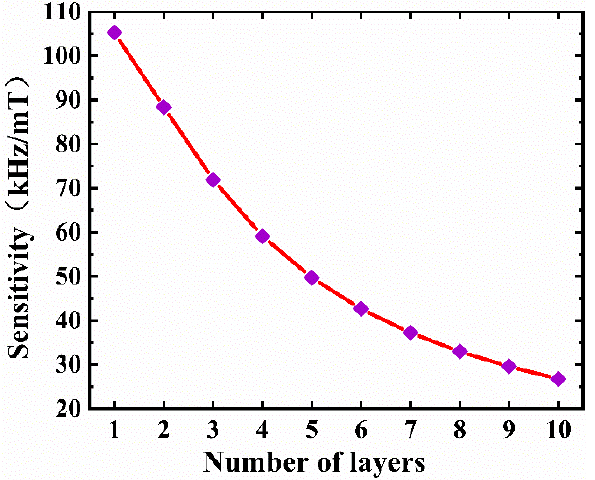
Figure 7. Variation of the sensitivity of the magnetic sensor with the number of graphene layers.